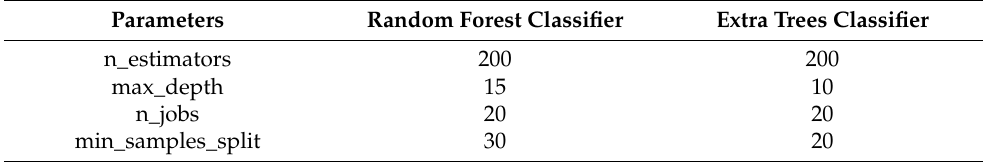
Table 3. The parameters selected for Random Forest Classifier and Extra Trees Classifier. Parameters Random Forest Classifier Extra Trees Classifier